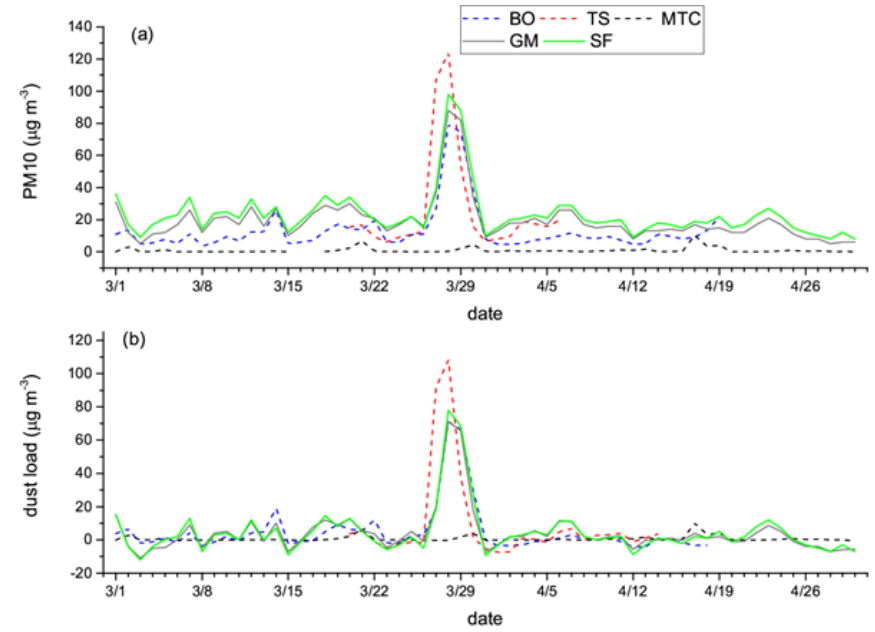
Figure 7. Daily mean PM 10 values (a) and dust load (b) calculated over the March–April 2020 period. Dashed lines represent values calculated from the counts of the optical particle counters in Bologna (BO), Trieste (TS), and Mt. Cimone (CMN), while solid lines represent concentration values recorded in Bologna at two air quality stations from the network (Giardini Margherita, GM, and Porta San Felice, SF). (Please note that dates are displayed using a month/day format in this